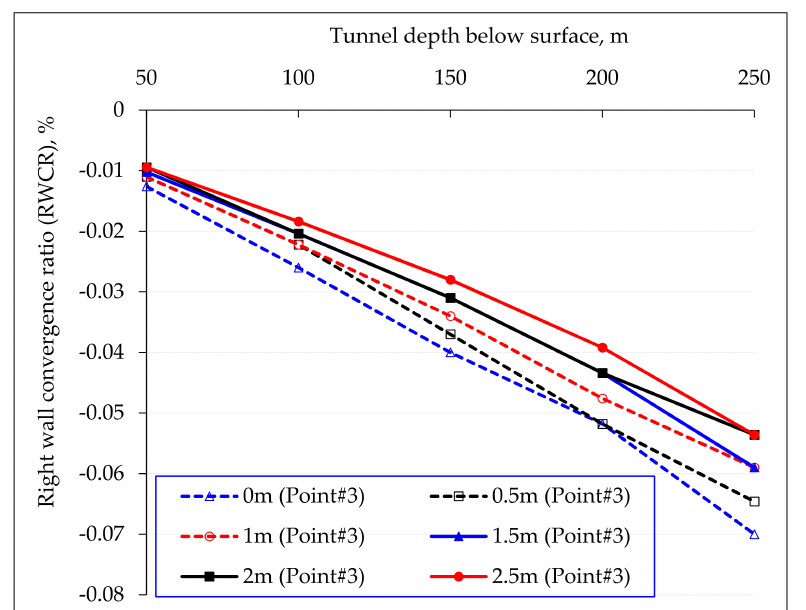
Figure 15. Convergence ratios of tunnel right wall (RWCR) at various tunnel depths below surface measured at different lateral distances from (e.g., reference point #3) the tunnel perimeter.